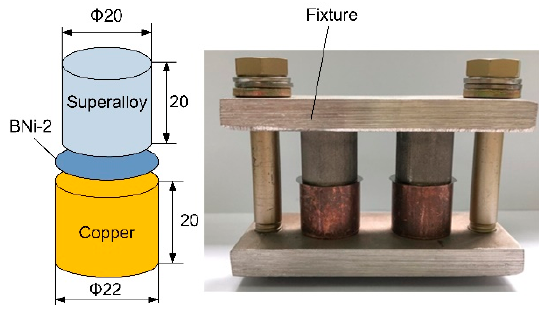
Figure 1. Dimensions (mm) and bonding setup of test specimens.